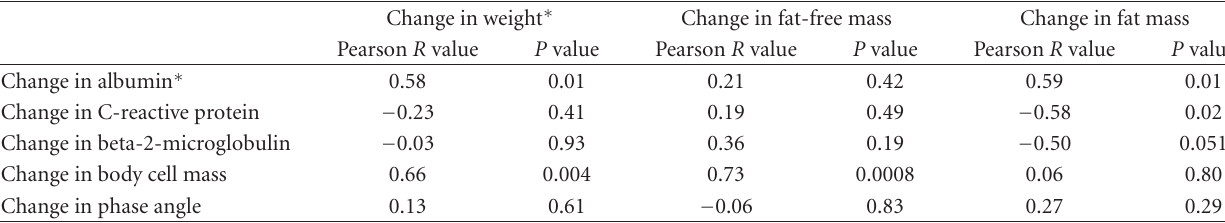
Table 3: Relationships of change in weight, body composition, and acute phase